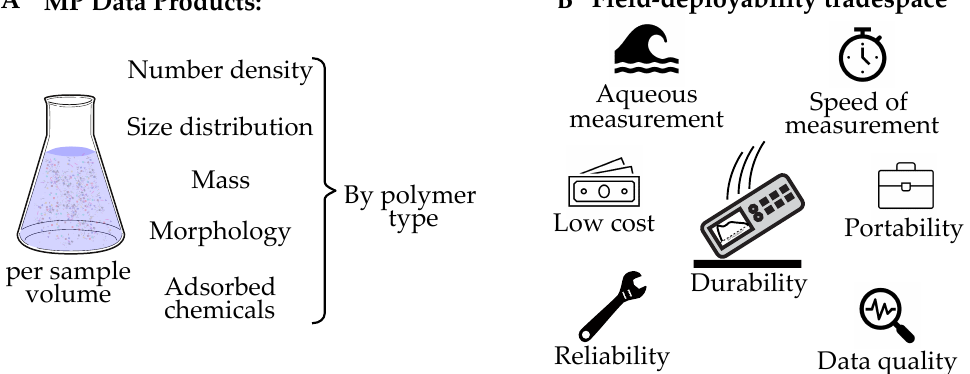
Figure 1. ( A ) Microplastic data products that can be collected from aqueous samples. MP number density, size distribution, mass, morphology, and adsorbed chemicals can all be further refined by measuring them by polymer type. ( B ) The key characteristics that define the field-deployable tradespace for a microplastic measurement technique for aqueous